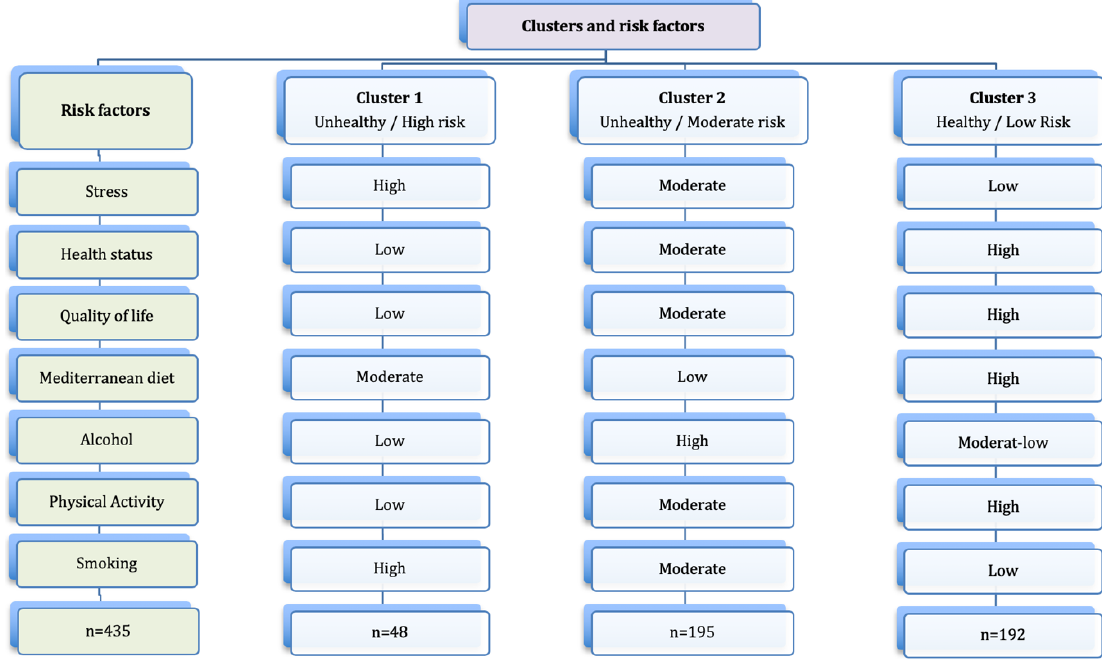
Table 5. Characteristics of the three clusters ( n = 435).